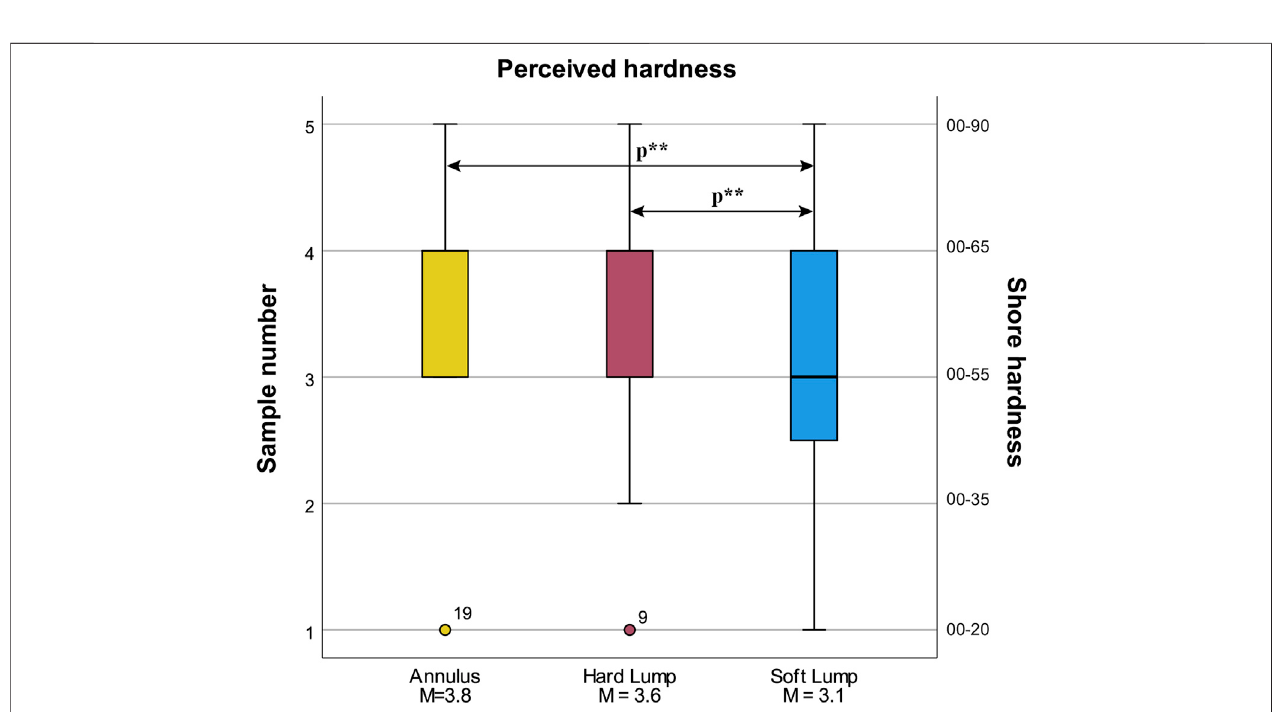
FIGURE 12 | Box plot of perceived hardness (subjective) for the three lump conditions. Statistically signi fi cant differences at p < 0.05 are indicated by p **.